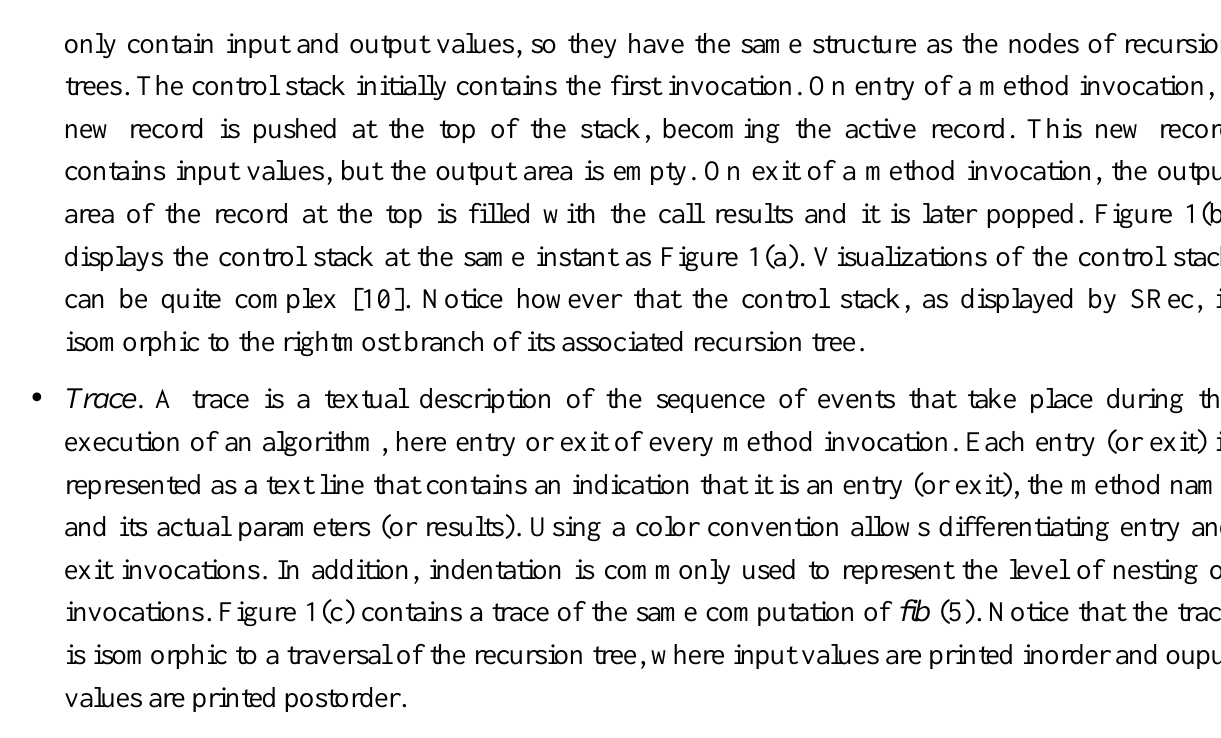
Figure 1. Three visualizations of fib (5): (a) recursion tree, (b) control stack, and (c)